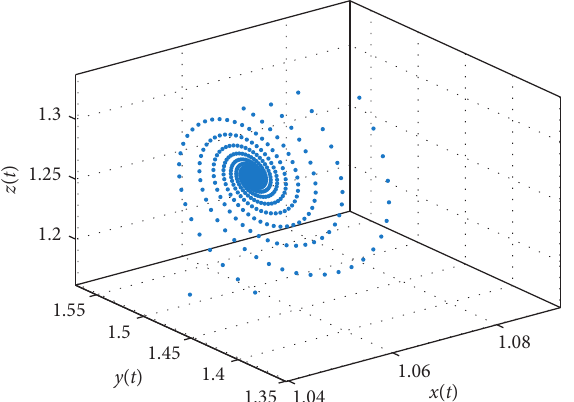
Figure 11: Strange attractors for α